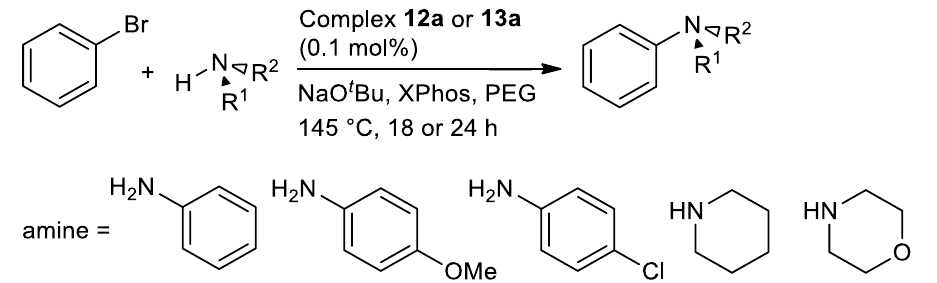
Figure 7. Representative metal complexes of thiosemicarbazones as catalysts for carbon–heteroatom coupling reactions.